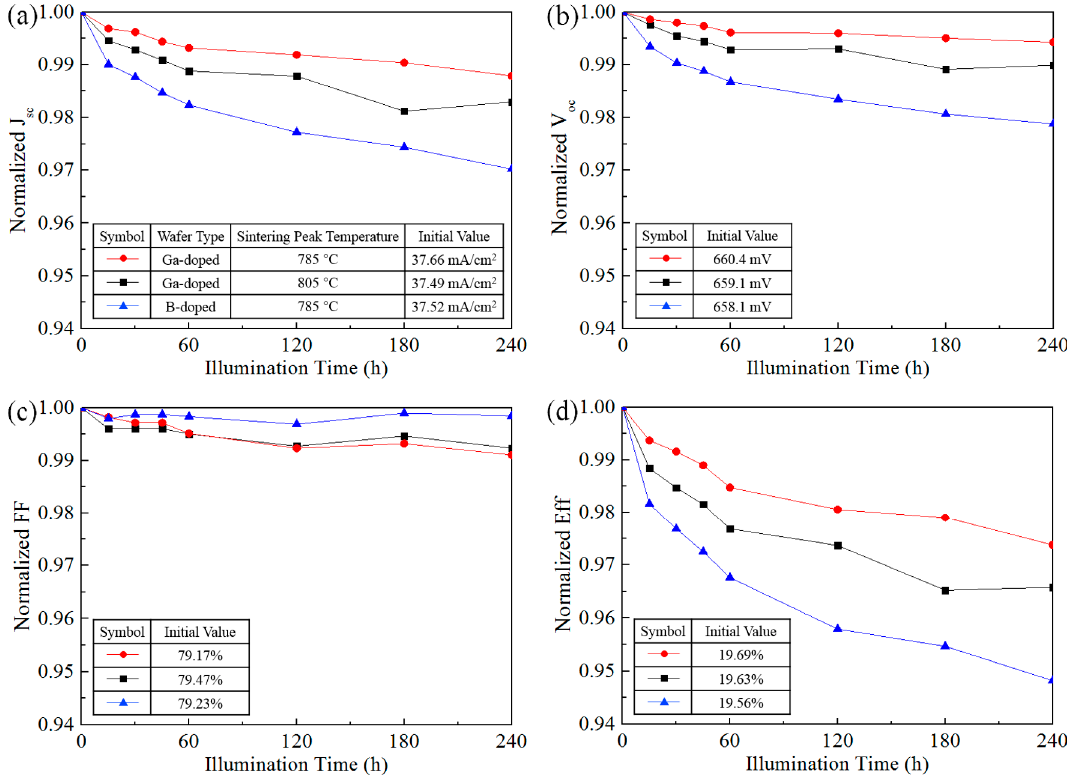
Figure 4. ( a ) Short circuit current density decay, ( b ) open circuit voltage decay, ( c ) fill factor decay, and ( d ) conversion efficiency decay of mc-Si PERC solar cells with different dopants (i.e., boron or gallium) and sintering peak temperatures (785 or 805 °C) due to illumination. These data were normalized, and the corresponding initial values are listed. For each kind of solar cell, 10 samples were chosen at random, and the average values of photovoltaic parameters and degradation ratios were extracted. Table 1. Change in short circuit current density ( J sc ), open circuit voltage ( V oc ), fill factor ( FF ) and conversion efficiency ( Eff ) of mc-Si PERC solar cells with different dopants (i.e., boron or gallium) and sintering peak temperatures (785 or 805 °C) after 240 h of illumination.